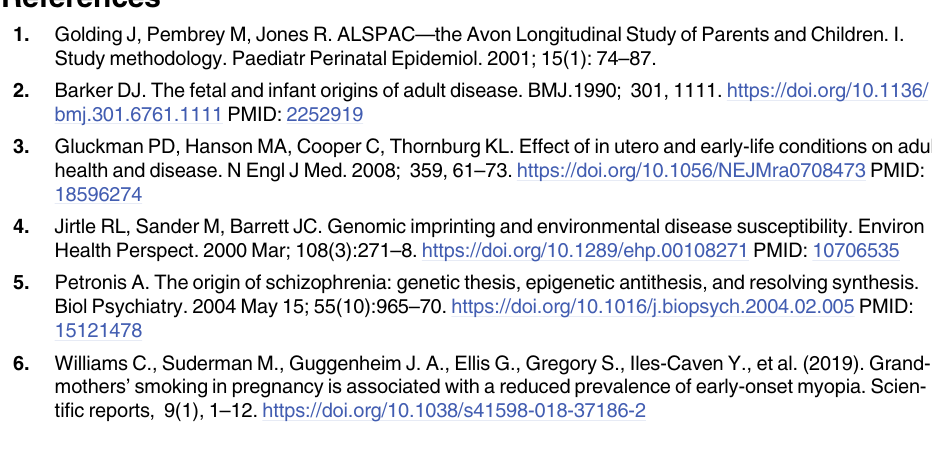
S3 Table. a. Unadjusted mean stereo by maternal grandmother smoked. b. Unadjusted mean stereo by paternal grandmother smoked. [P values < 0.10 are in bold]. S4 Table. Highest 10% of stereo level chosen by the children at age 11 according to features of their grandparents. [P values < 0.10 are in bold]. S5 Table. Risk of the child having a flat acoustic reflex at age 11 if the maternal grand- mother had smoked in pregnancy. [P values < 0.10 are in bold]. S6 Table. The prevalences of hearing features of the children at age 11 according to whether a grandmother had smoked prenatally when expecting the study